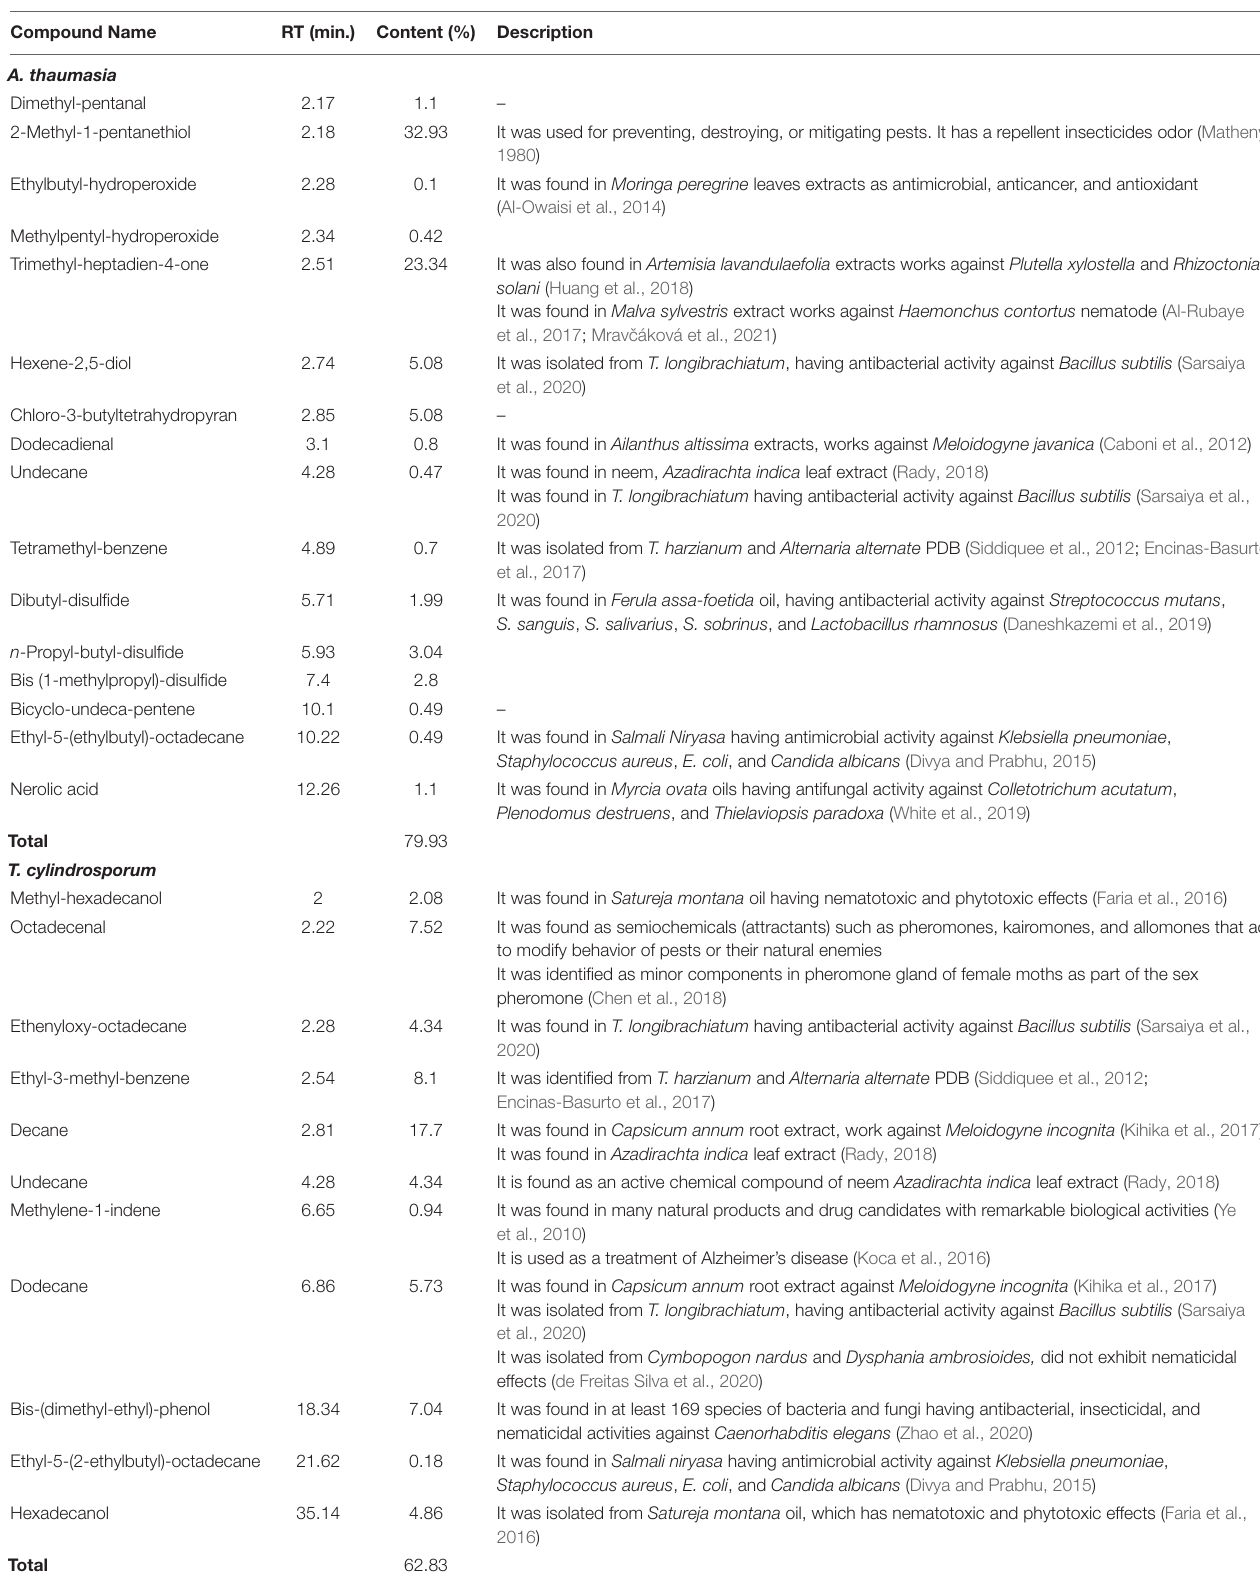
TABLE 2 | Identification of volatile organic compounds (VOCs) of A. thaumasia and T. cylindrosporum using GC–MS